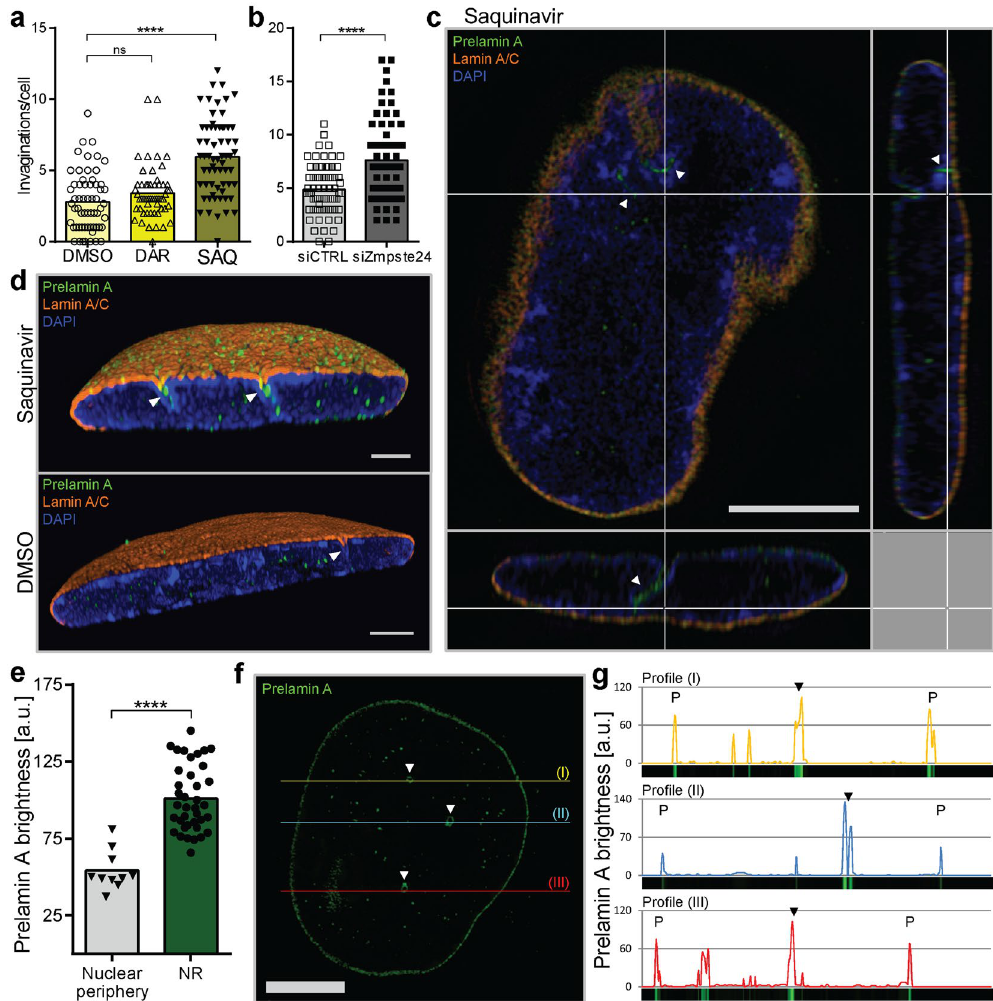
Figure 2. NR formation in response to prelamin A accumulation. Mean frequency of NR tubules in cells accumulating prelamin A under saquinavir treatment (SAQ) ( a ) and Zmpste24 siRNA knock-down (siZmpste24) ( b ) with corresponding controls: DMSO (vehicle), DAR (darunavir), and control siRNA (siCTRL); results from four independent experiments, 30 nuclei each. ( c ) Super resolution light microscopy on saquinavir-treated early passage HDFs with arrowheads pointing towards NR channels; scale bar, 5 µ m. ( d ) 3D reconstruction of super resolution light microscopy data of cells treated with either saquinavir or DMSO; scale bar, 2 µ m. ( e ) Quantification of prelamin A signal at nuclear periphery and NR channels; n = 10 nuclei. ( f ) An example of mid-section showing prelamin A immunostaining with arrowheads pointing towards NR channels; scale bar, 5 µ m. ( g ) Prelamin A brightness along the color-coded profiles drawn in ( f ); black arrowheads correspond to NR channels, while “P” indicates nuclear periphery region. **** p < 0.0001; ns, p not